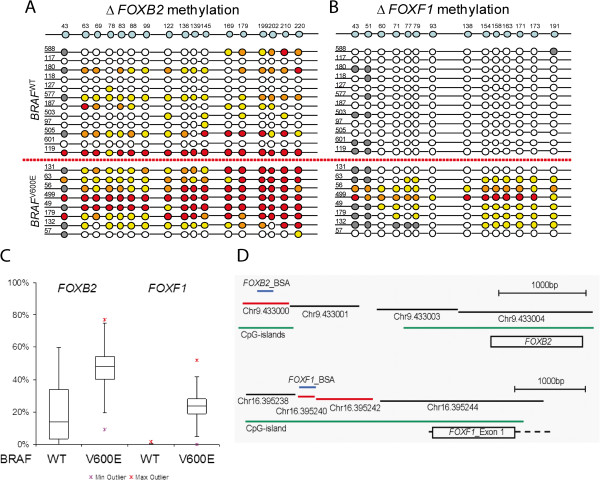
Tumor hypermethylation of FOXB2 and FOXF1. (A, B) Bisulfite sequence results for 12 BRAF wildtype tumors and 8 BRAF mutant tumors, separated by the horizontal red line. Schematic display of the BSA region with CpG locations therein shown on top (blue). Sample IDs are given on the 5' end of the BSA region. Each circle depicts a CpG. Color code: gray = ND, white = 0% to 20%, yellow = 20% to 40%, orange = 40% to 60%, red > 60% methylation. (C) Boxplot showing average methylation percentage over all detected CpGs in BRAF wildtype and BRAFV600E tumors for FOXB2 (left) and FOXF1 (right). The box indicates the 25 and 75 percentiles, with the median shown in bold. Upper and lower outliers are shown as red and purple asterisks, respectively. (D) Schematic display of FOXB2 (top) and FOXF1 (bottom) loci depicting the location of the BSA regions in relation to MseI fragments detected on the Agilent array (significant fragments marked red, not significant as black). CpG islands are shown in green, and the BSA region is shown in blue.